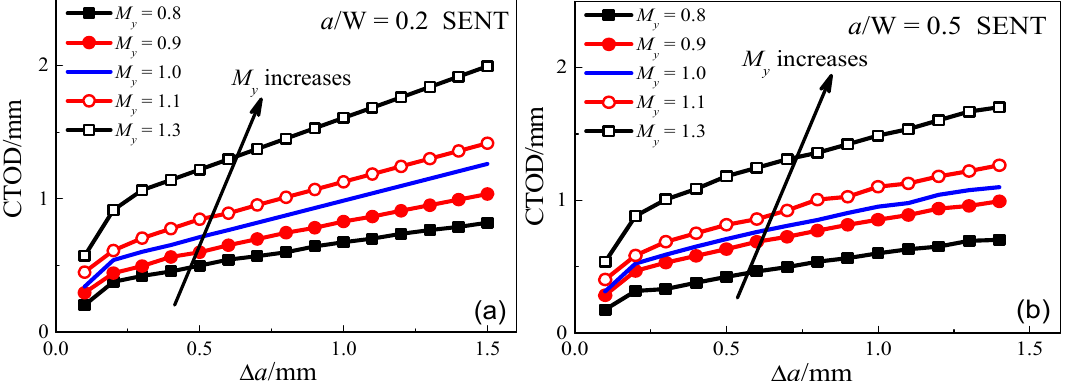
Figure 7. CTOD– ∆ a curves for shallow- and deep-cracked SENT specimens with different mismatch ratios, ( a ) a / W = 0.2; ( b ) a / W = 0.5.